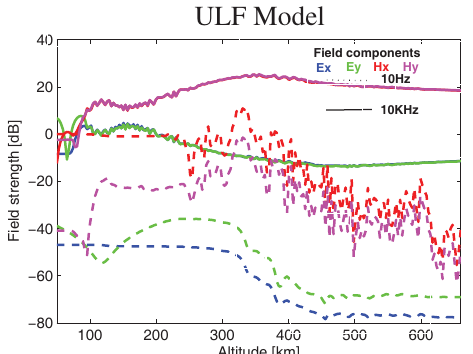
Figure 5. Intensity of four horizontal components of electric and magnetic field varying with altitude at 10kHz (solid line) and 10Hz (dashed line) calculated with our ULF model(blue lines represent E x ; green lines represent E y ; red lines represent H x ; purple lines represent H y ).